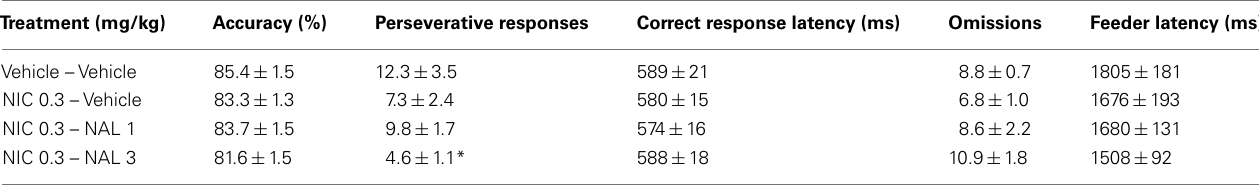
Table 2 | Effects of the opioid receptor antagonist naloxone (NAL) on measures of attentional function, compulsivity, and motivation in the 5-CSRTT following a challenge injection with the psychostimulant nicotine (NIC). Treatment